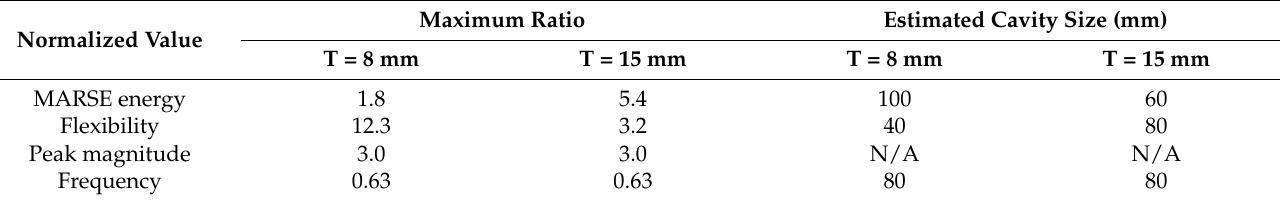
Table 2. Maximum ratios between cavity and soil sections for each normalized value and estimated cavity size. Normalized